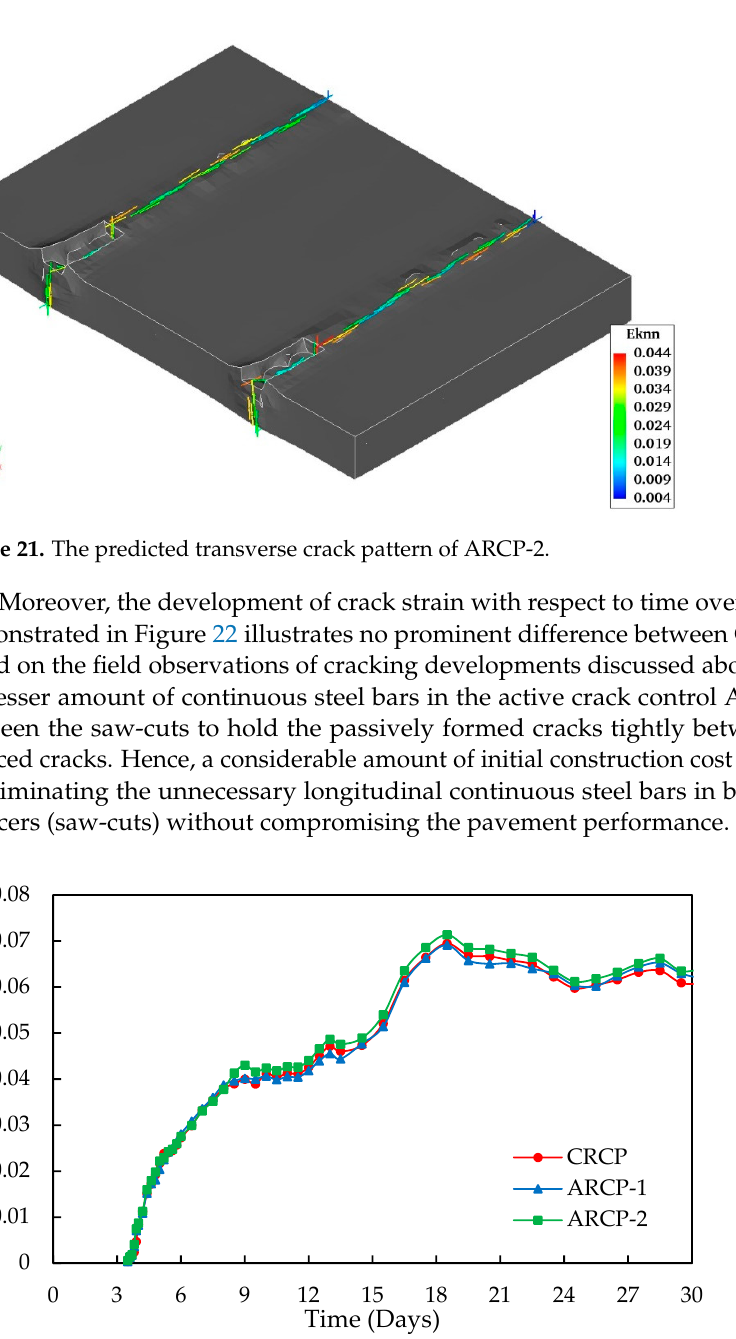
Figure 20. The predicted transverse crack pattern of ARCP-1.